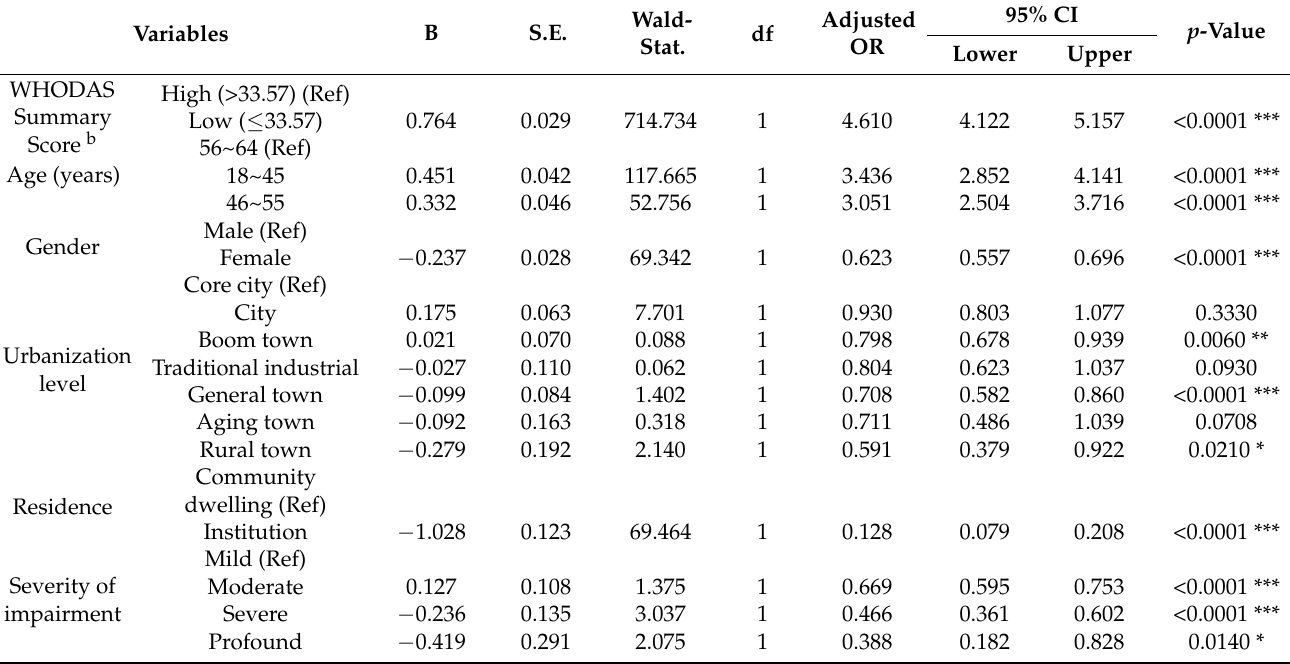
Table 4. Logistic regression results on the effects of demographic factors on employment status ( n = 9886) a